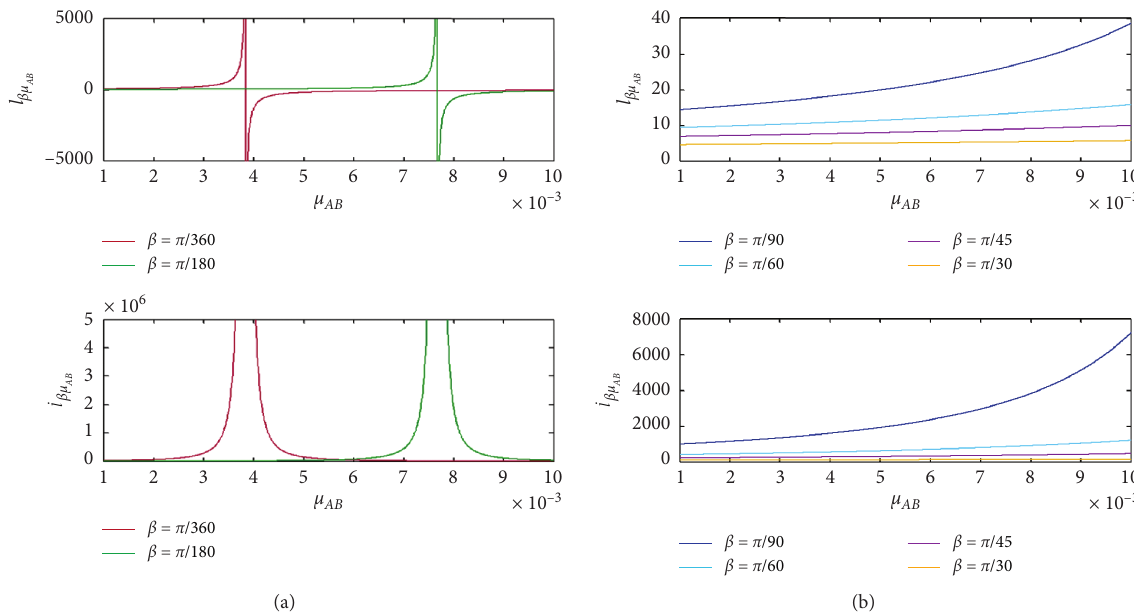
Figure 6: The relationship of the gravity block length l the stability angle ϕ � ( π /4 ) and different well inclination angles β .